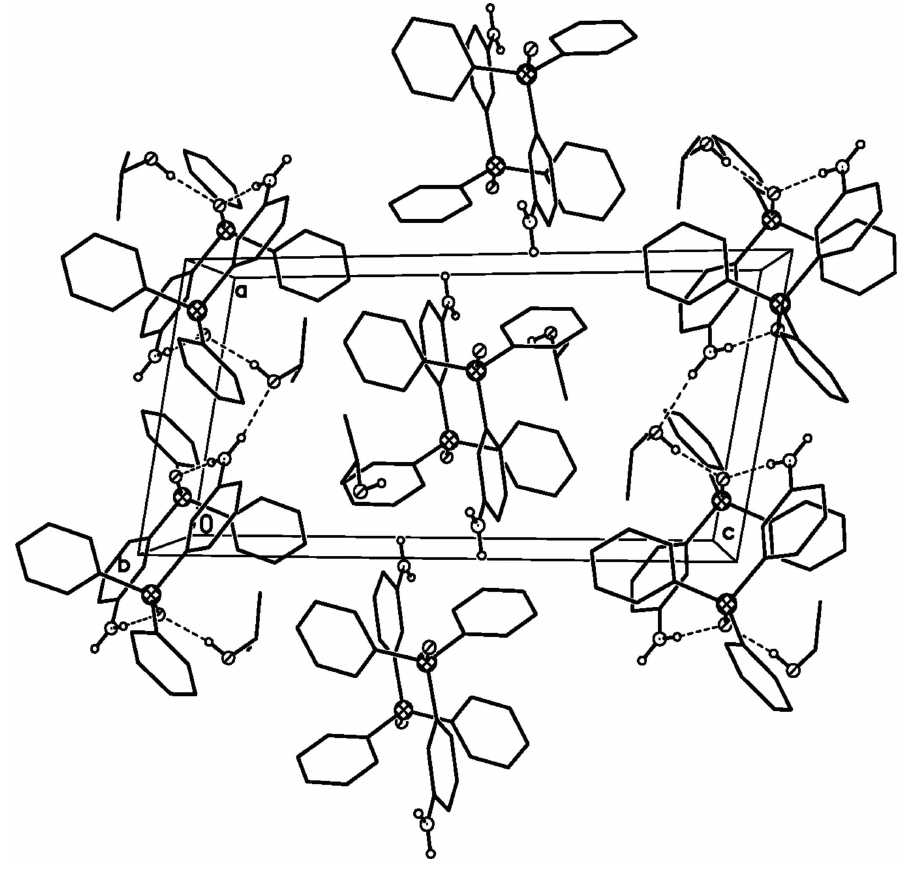
Figure 2 Crystal packing diagram of the title compound (along b crystal axis). Hydrogen atoms that do not take part in hydrogen bonding are not depicted for clarity. Hydrogen bonds are shown with dashed lines.